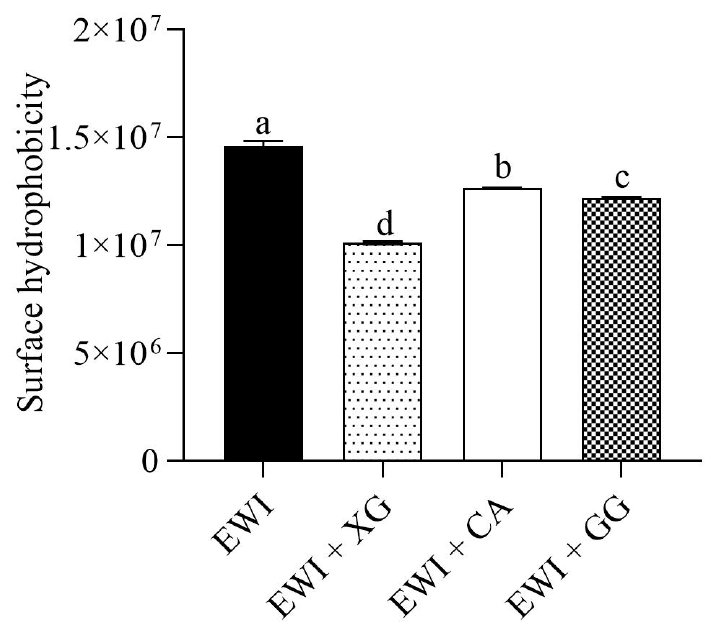
Figure 7. Effects of polysaccharide added to egg white liquid on surface hydrophobicity. Different letters indicate significant differences ( p < 0.05) between groups.